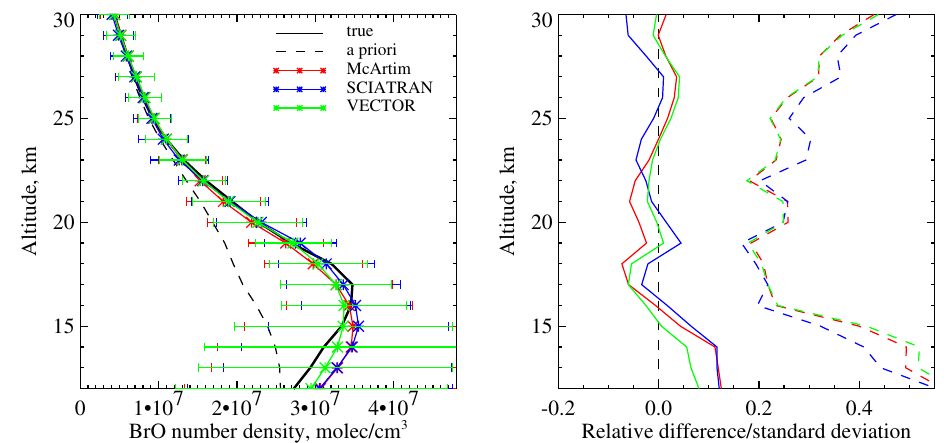
Fig. 10. Synthetic retrievals for an observation geometry typical for high-latitude spring season. Left panel: mean vertical profiles of BrO retrieved with the IUP Bremen algorithm using synthetic limb spectra simulated with different radiative transfer models (colored solid lines with asterisks). The true and a priori profiles are shown with black solid and dashed lines, respectively. Right panel: relative deviations from the true profile (solid lines) and standard deviations (dashed lines) for different retrievals.